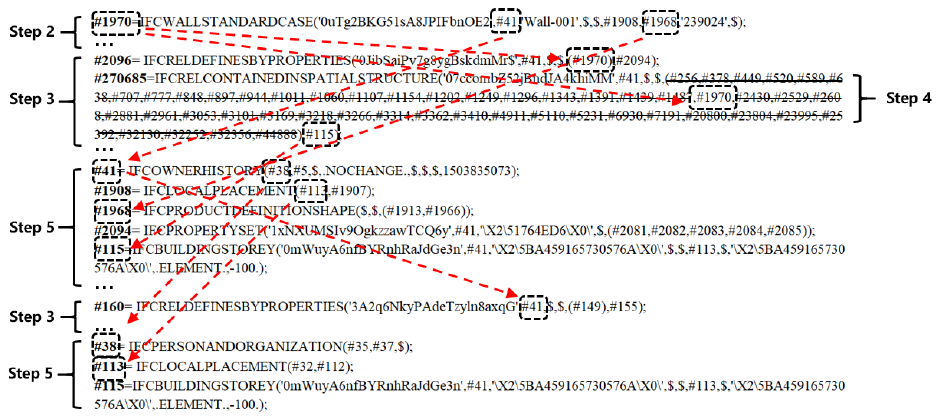
Figure 4. Iteration of component extraction based on the IFC physical file.